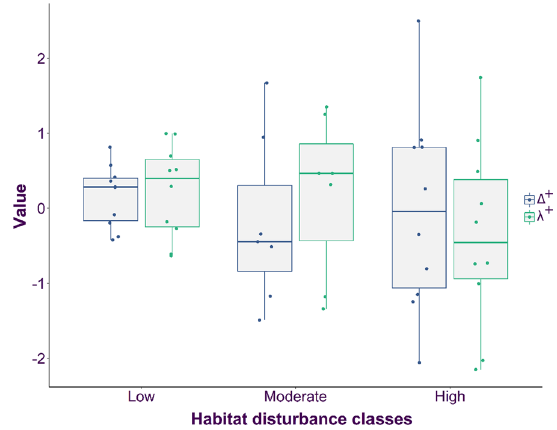
Fig. 8 Boxplot comparing taxonomic distinctness (Δ + ) and index of variation in taxonomic distinctness (λ + ) of spider community between the lowly, moderately, and highly disturbed sites along the Ganga River, India (for Δ + Kruskal–Wallis χ 2 0.984, df 2, p > 0.05; for = = λ + Kruskal–Wallis χ 2 2.024, df 2, p > 0.05). Each box represents the = = 25%/75% quartiles, and the median is shown with a horizontal line